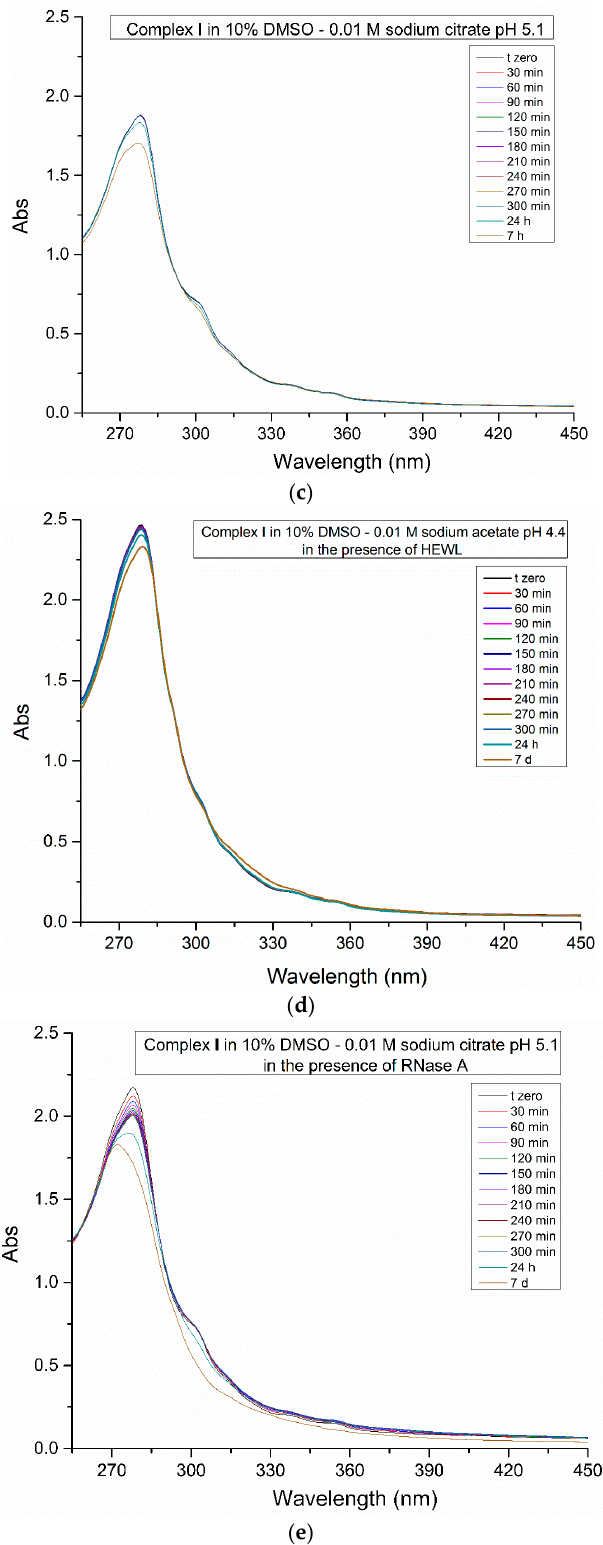
Figure 2. Time dependent UV–Vis absorption spectra (up to 7 days) of 5 × 10 − 3 M complex I in 100% DMSO ( a ), 90% DMSO–0.01 M sodium acetate buffer pH 4.4 ( b ), 90% DMSO–0.01 M sodium citrate buffer pH 5.1 ( c ). For the last two conditions, time-dependent UV–Vis absorption spectra have been registered also in the presence of hen egg white lysozyme (HEWL) ( d ) and bovine pancreatic ribonuclease (RNase A) ( e ),